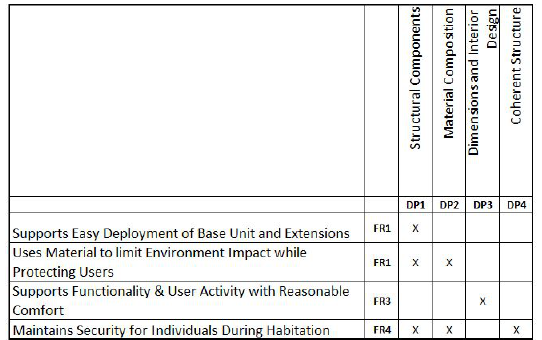
Figure 18. AD Top Level Design Mapping FRs to DPs (Level